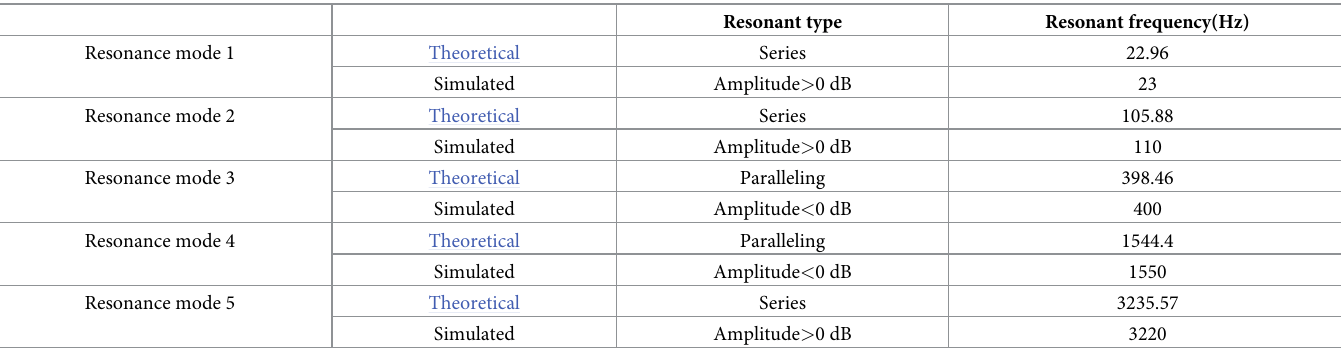
Table 4. Comparison of the resonance modes of CVT with a resonant damper.